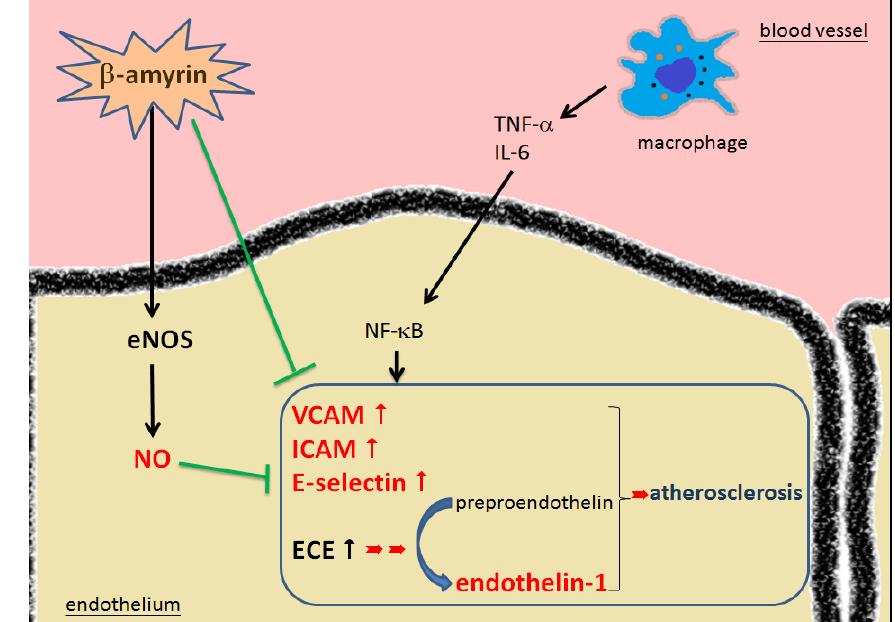
Figure 7. The effectiveness of β -amyrin modulates the development of atherosclerosis via adhesion